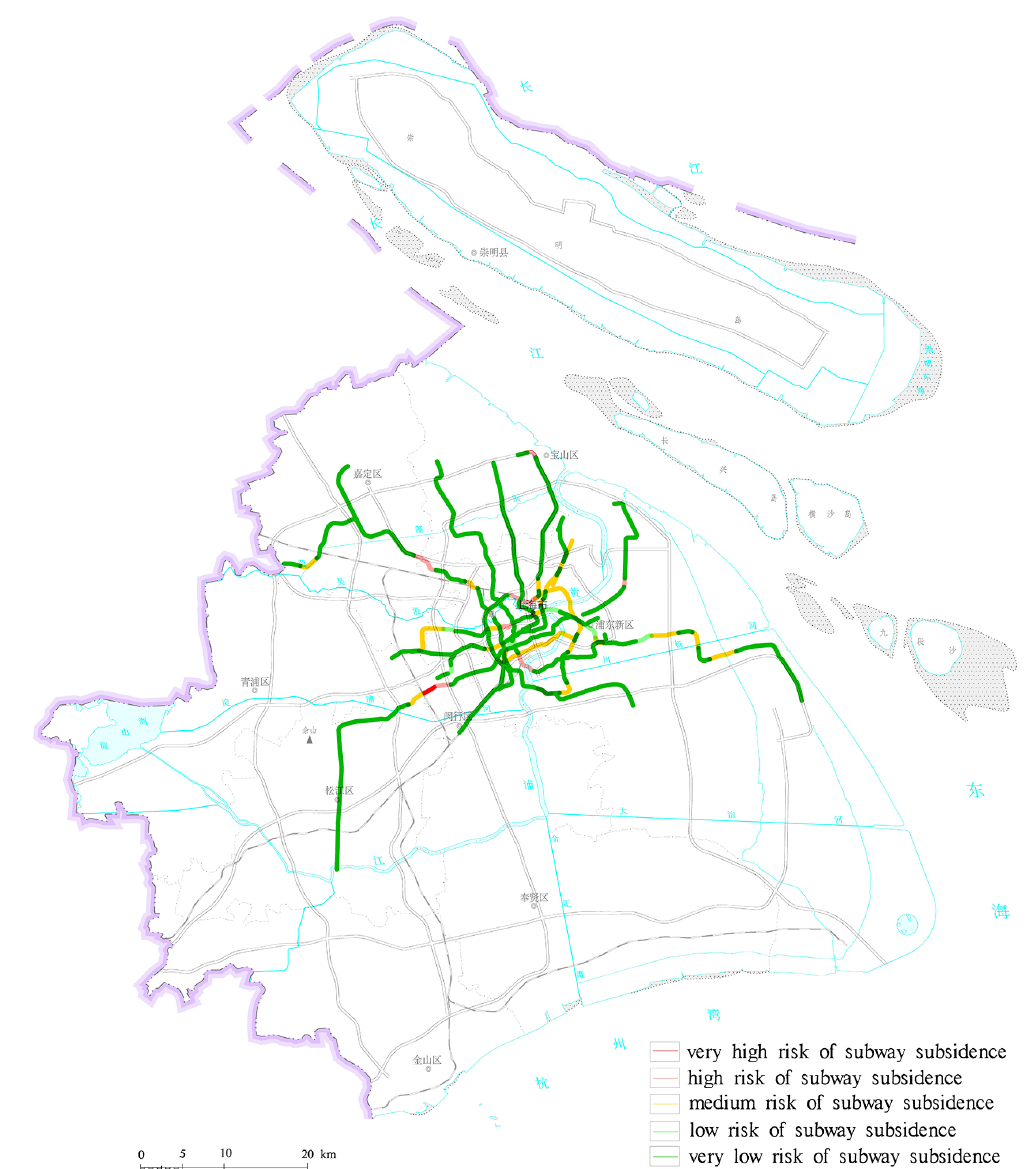
Figure 7. Risk evaluation of metro subsidence in